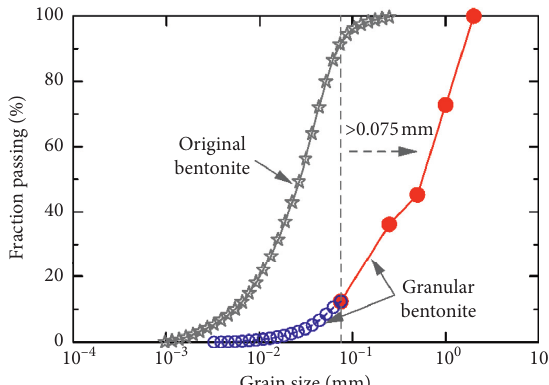
Figure 3: Grain size distribution curves before and after